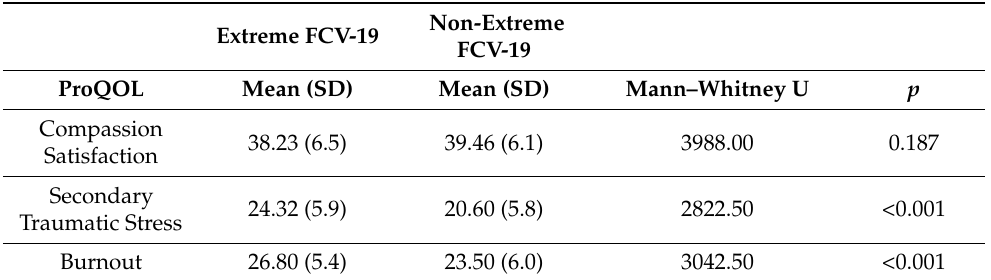
Table 2. ProQOL dimensions in MHWs with extreme ( n = 53) and non-extreme FCV-19 ( n =